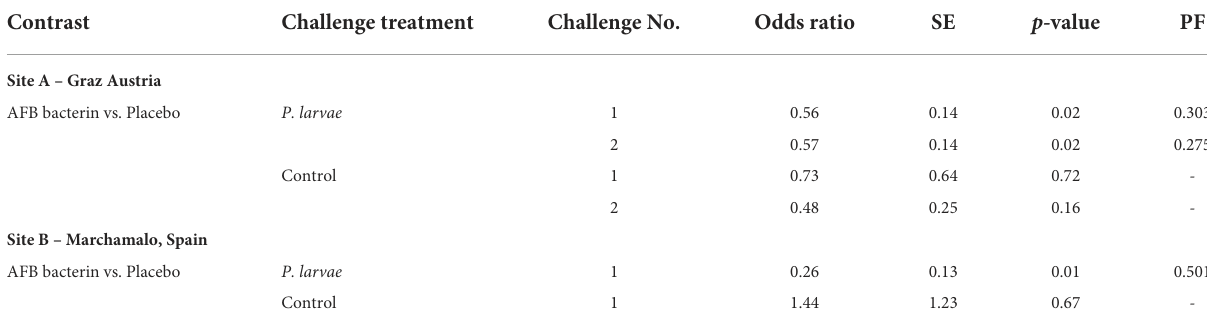
TABLE 2 The efficacy of the vaccination. Contrast Challenge treatment Challenge No.